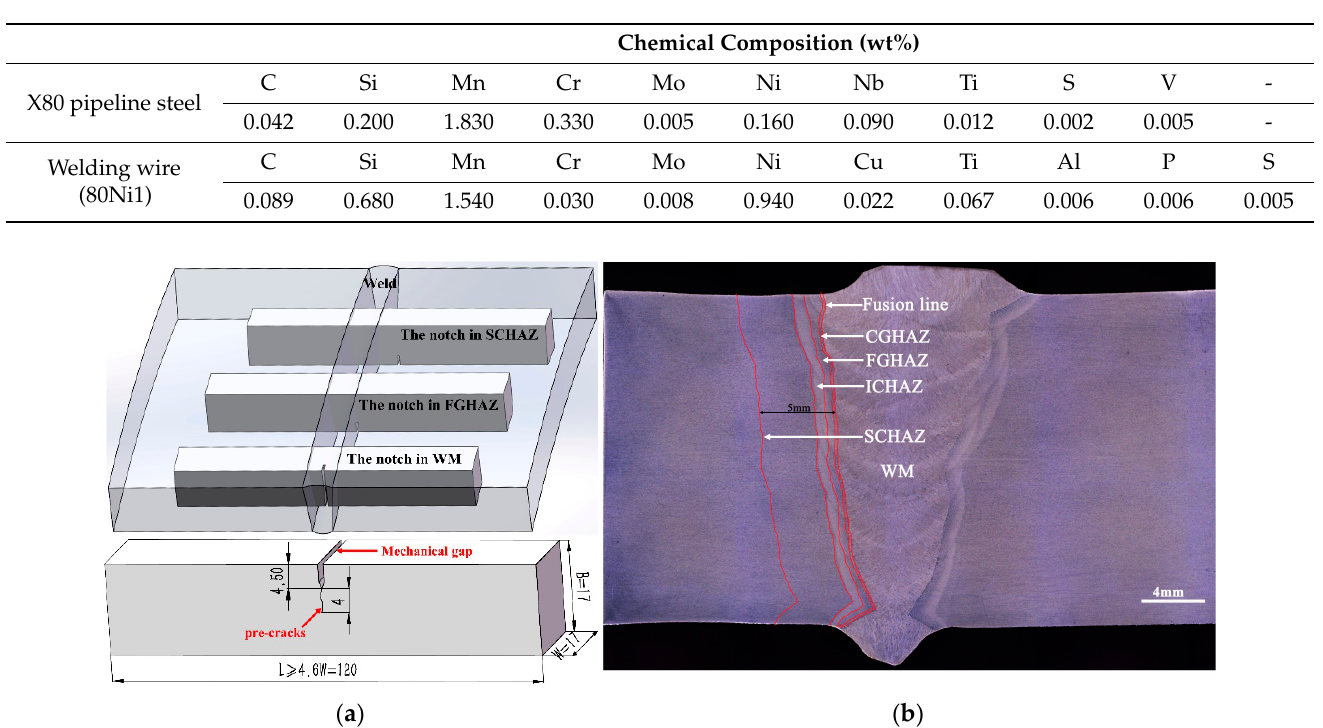
Table 2. The chemical composition of X80 pipeline steel and welding wire.